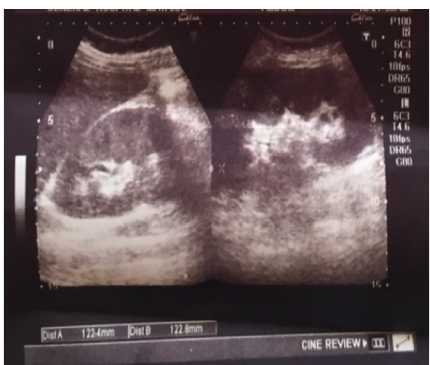
Figure 1: Ultrasound scan obtained 2 days prior to